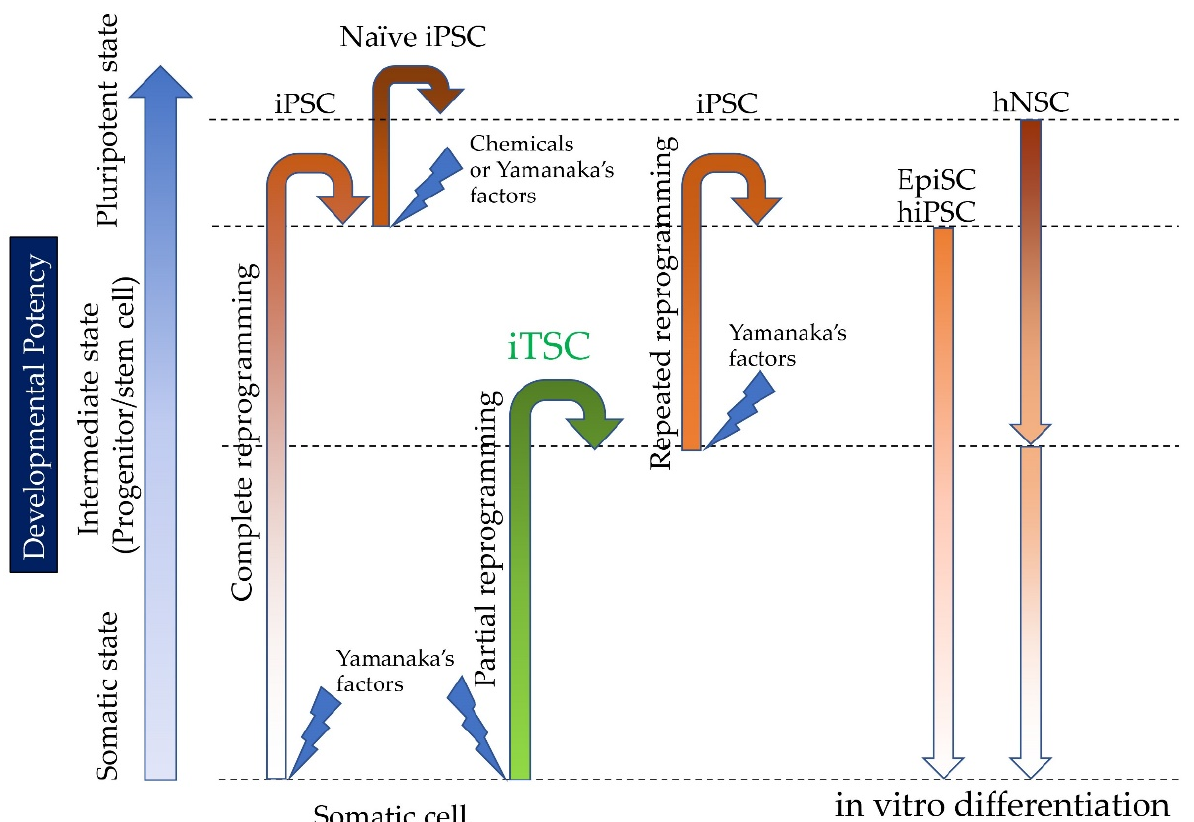
Figure 3. Somatic cells are converted into intermediate cells called iTSCs, when partial reprogramming occurs. These iTSCs can be further reprogrammed to form iPSCs via repeated transfection with vectors carrying Yamanaka’s factors. Epi-stem cells (EpiSCs; corresponding to human iPSCs) differentiate poorly upon induction, whereas naïve stem cells (NSCs; corresponding to mouse iPSCs and ESCs) do not. Because NSCs are thought to lose their epigenetic memory, they may be more efficiently induced to differentiate into various cell types (versus EpiSCs).